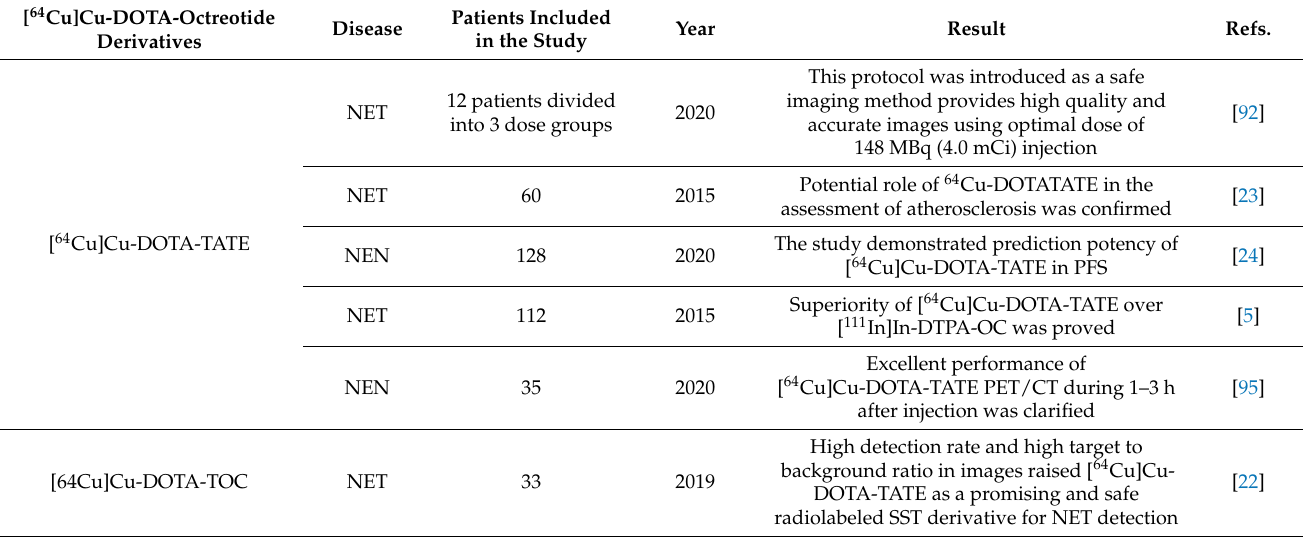
PFS: progression-free survival. SST: Somatostatin Receptor